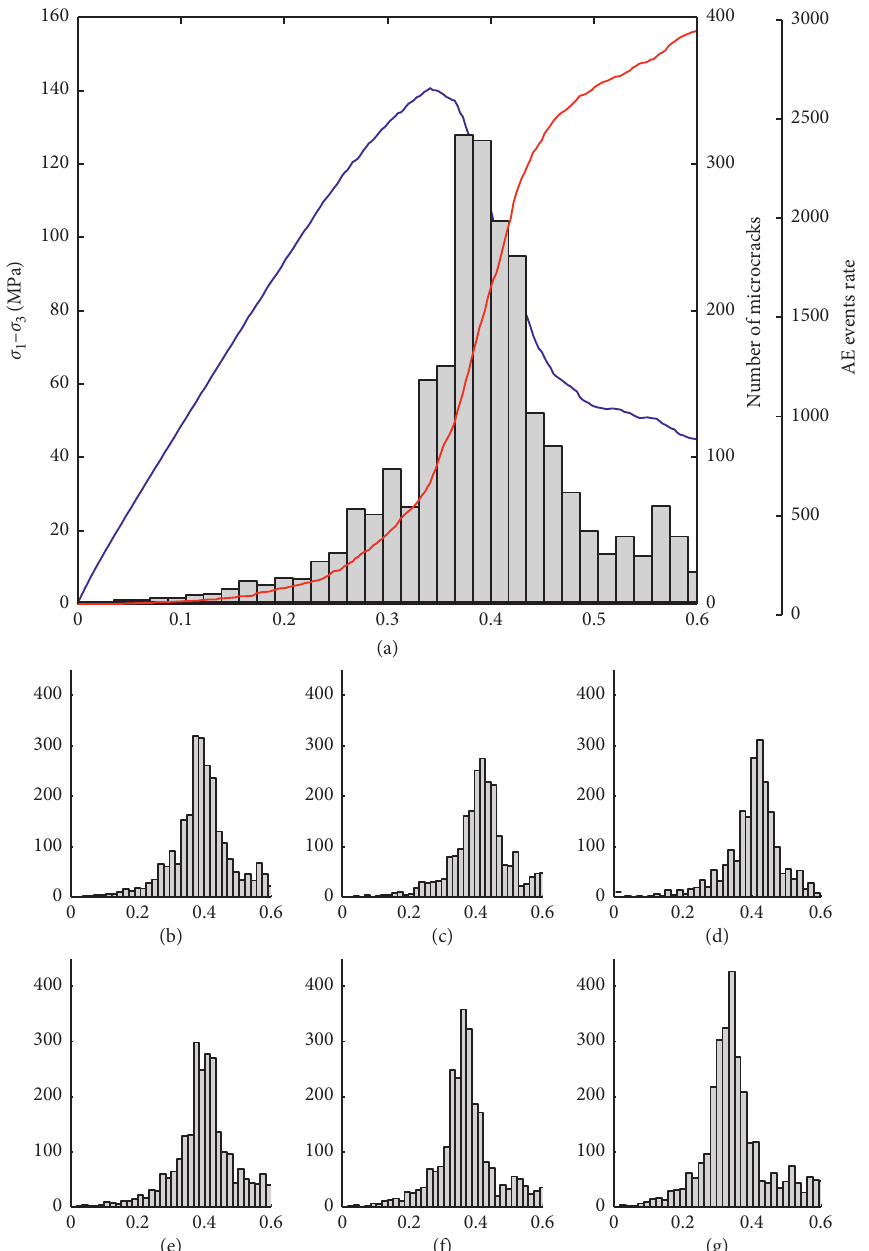
Figure 9: Acoustic emission events in different stress states. (a) b � 0, (b) b � 0, (c) b � 0.2, (d) b � 0.4, (e) b � 0.6, (f) b � 0.8, and (g) b �